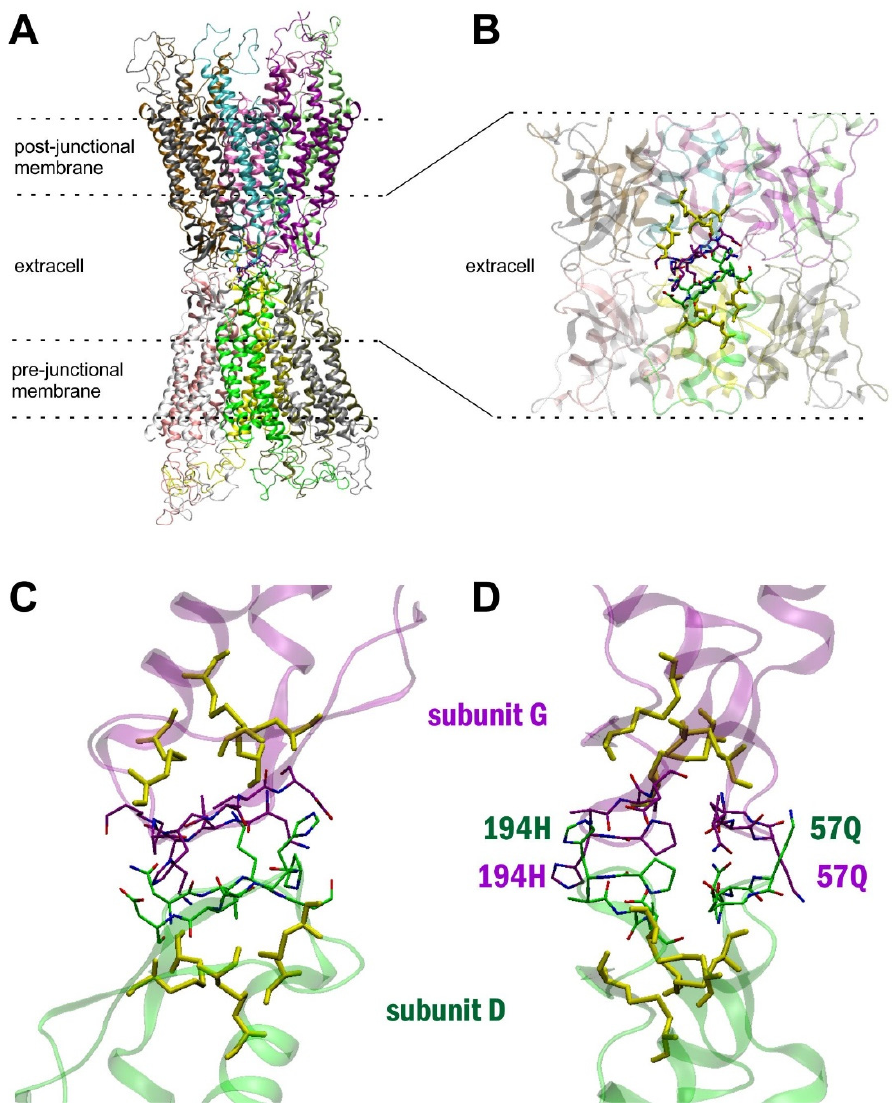
Figure 1. Structural design of amino acid residues filling the gap. ( A ): Full view of the Cx43 GJC homology model. Subunits are represented by different colours. ( B ): Extracellular loops of the Cx43 GJC homology model. Subunits are represented by different colours. Residues directly forming the GJ interface are shown in stick. ( C , D ): Mirror-apposition of pre-GJ “D” and post-GJ “G” subunits ( cf. SI Figure S3) showing amino acid residues within 10 Å both from the conserved pre- and post-GJ cystine disulfide frontiers from inside ( C ) and side ( D ) views. Green and purple sticks represent the amino acid residues of each subunit within 10 Å from the conserved cystine disulfides, shown in yellow sticks. EL2 194H and EL1 57Q residues are highlighted, indicating outer and inner gap boundaries, respectively.